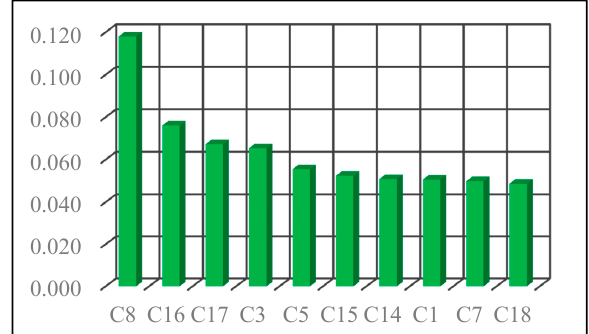
Figure 6. Critical risk categories and criteria weights.